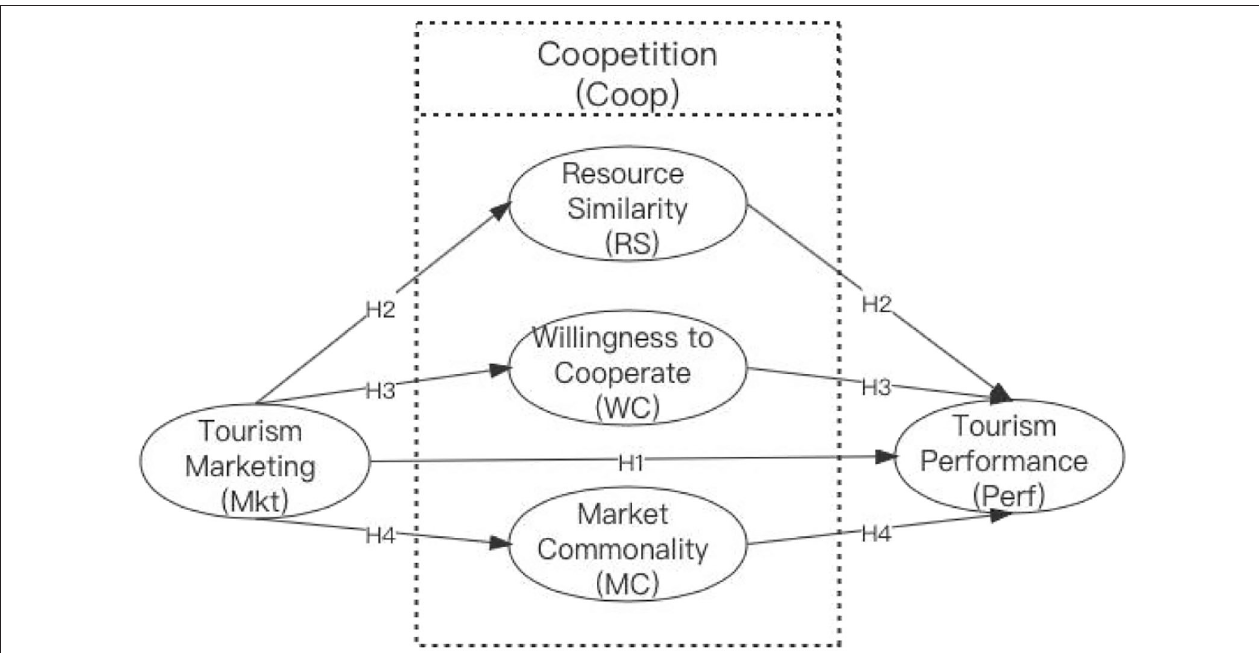
FIGURE 1 | Proposed theoretical